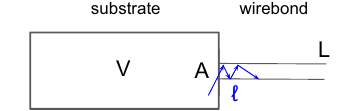
Fig. 5 Device schematic for phonon escape. Phonons are uniformly moving in a substrate of volume V , and can escape through N w wire bonds each with area A . The escape rate is proportional to the phonon velocity v p . The phonons must diffuse down the wire bond, eventually escaping with a probability ℓ / L , where L is the wire bond length and ℓ is the mean free path taken as the wire bond diameter. The escape rate is given by Eq.